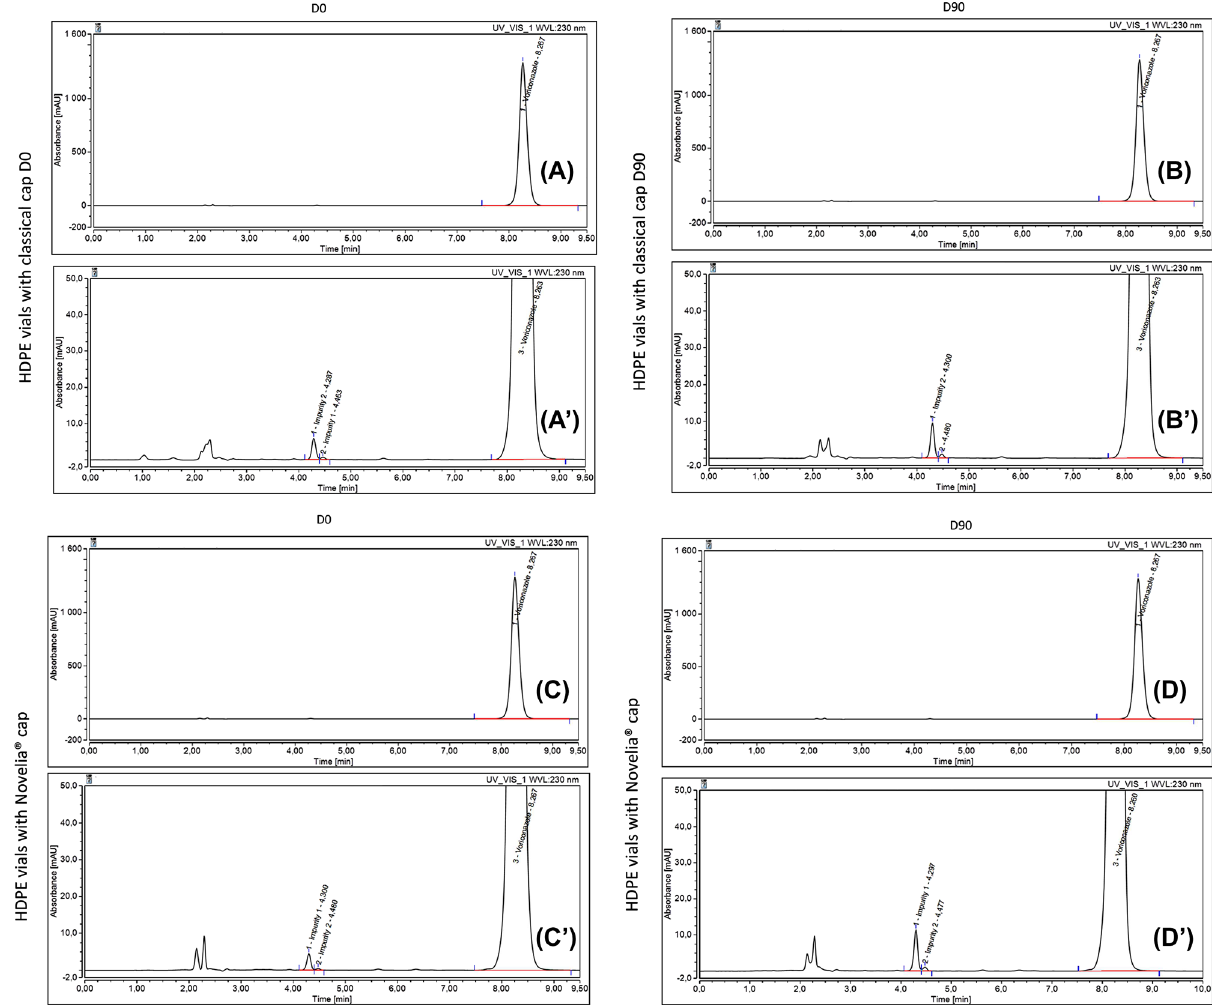
Figure2: Chromatogramsofvoriconazoleeyedropsolutions5mg/mLinHDPEvialswithclassicaleyedropinsertatD0(A)etD90(B)andHDPE vials with Novelia ® insert at D0 (C) and after 90 days (D) of storage at + 2 to 8 ° C. (A ′ ), (B ′ ), (C ′ ) and (D ′ ) are respectively the close-up of the chromatogram